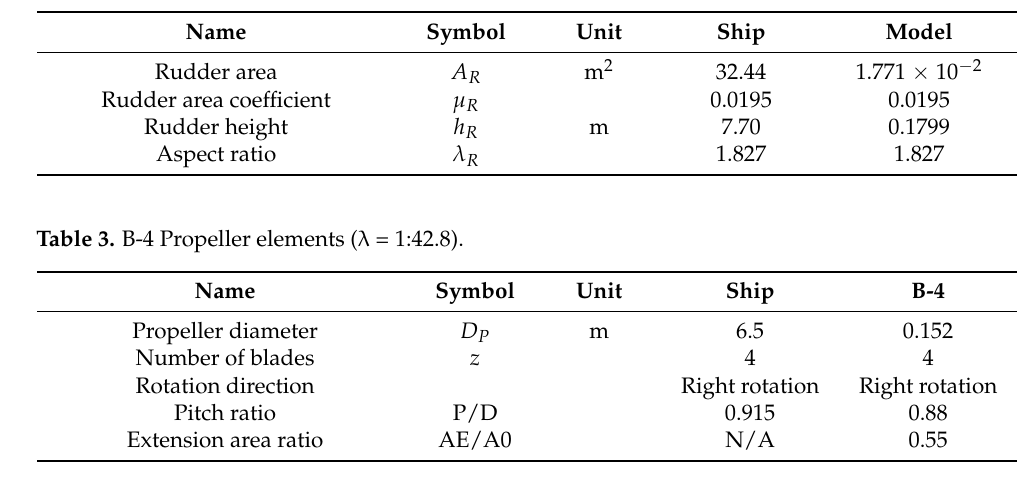
Table 2. NACA rudder elements ( λ = 1:42.8).